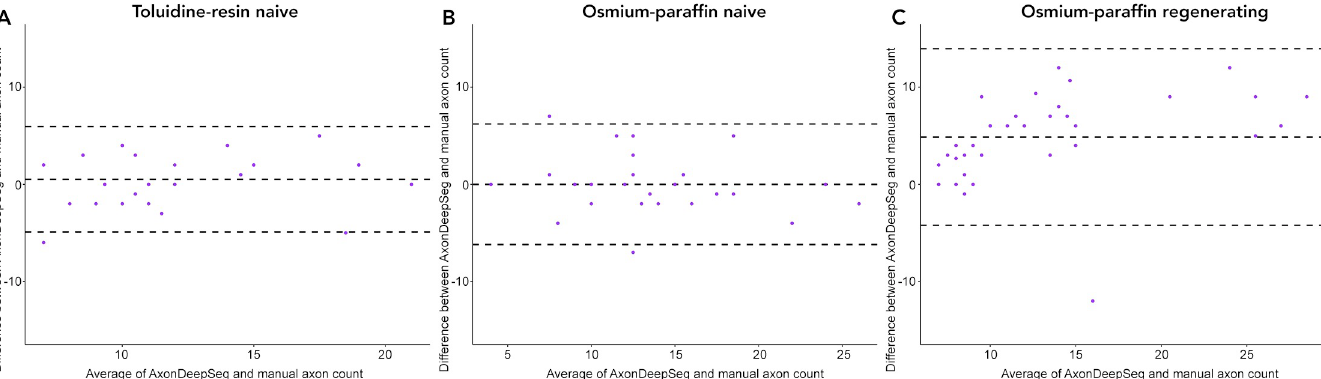
Fig 4. Bland-Altman plots of ADS and manual axon counts. (A) In na ï ve nerves prepared with the toluidine-resin protocol, the limits of agreement between ADS and manual counts in the 625 μ m 2 sample area in each micrograph ranged from -5 to 5. (B) In na ï ve nerves prepared with the osmium-paraffin protocol, the limits of agreement between ADS and manual counts in the 625 μ m 2 sample area ranged from -6 to 6. (C) In regenerating nerves prepared with the osmium-paraffin protocol, the limits of agreement between ADS and manual counts in the 1600 μ m 2 sample area ranged from -2 to 12.